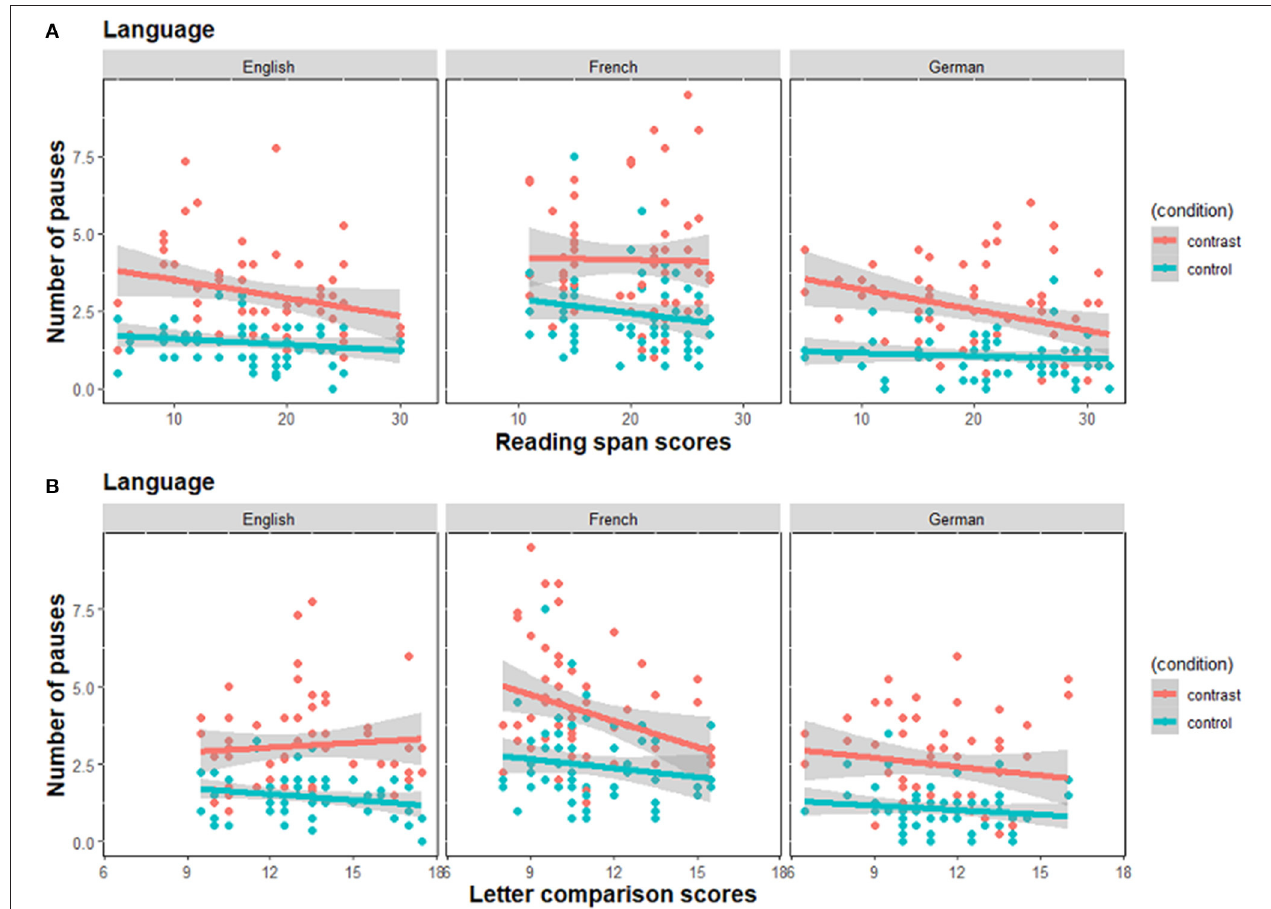
FIGURE 4 | Average number of pauses per utterance as a function of (A) working memory scores as measured by the reading span task, and (B) speed of processing scores as measured by the letter comparison task. The gray bands represent 95% confidence interval for the regression lines. Contrast, Contrast condition; control, Control